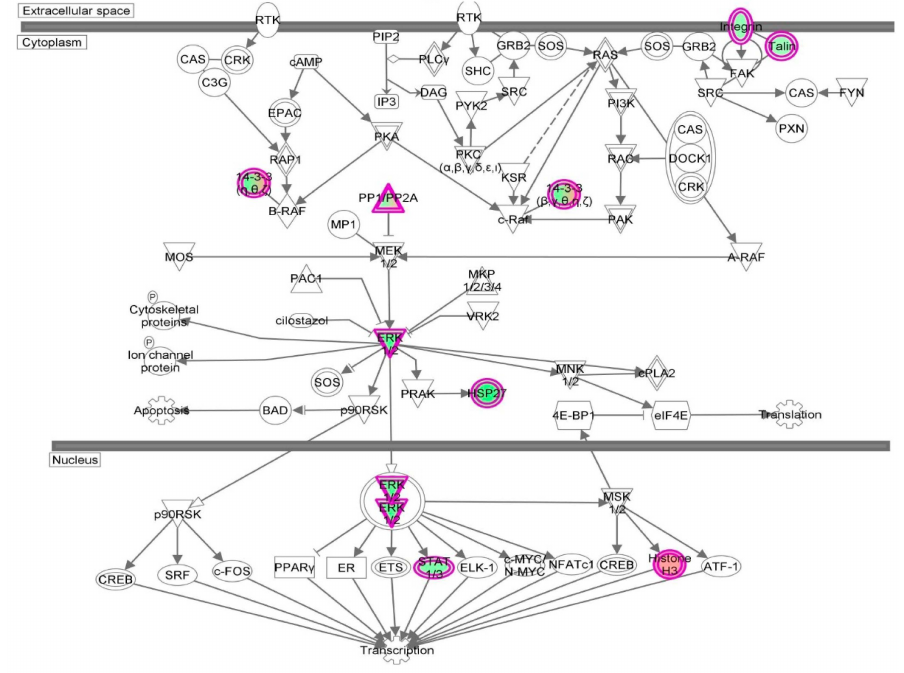
Figure 37. ERK-MAPK signaling pathway was regulated by vancomycin in HK-2 cells. HK-2 cells were treated with 50 µ g/mL vancomycin for 24 h and the protein samples were subject to quantitative proteomic analysis. Red indicates an up-regulation; green indicates a down-regulation. The intensity of green and red colors indicates the degree of down- or up-regulation. Solid arrow indicates direct interaction and dashed arrow indicates indirect